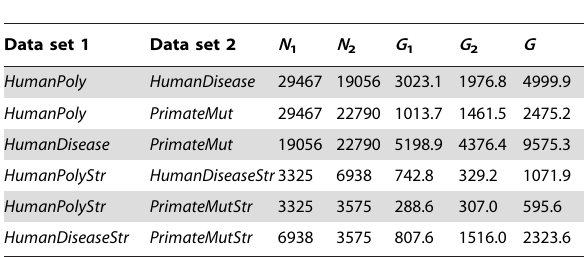
Table 3. The G values for different datasets against